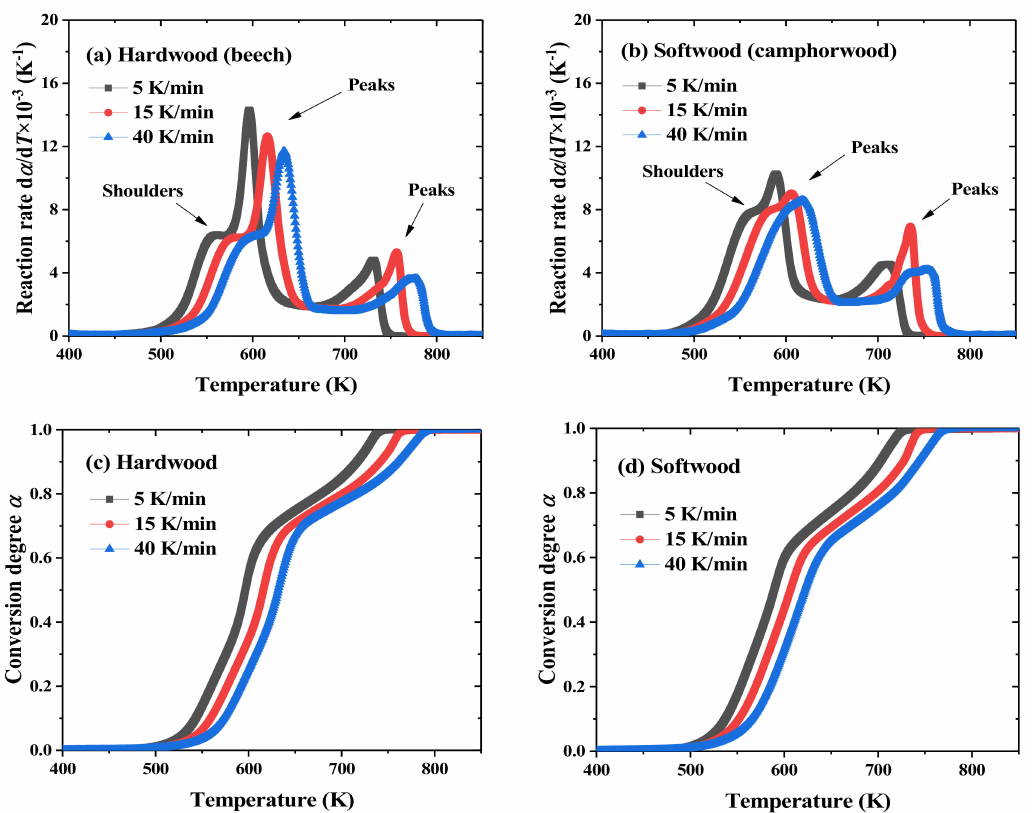
Figure 2. The d α /d T and α curves of beech and camphorwood degradation at various heating rates.